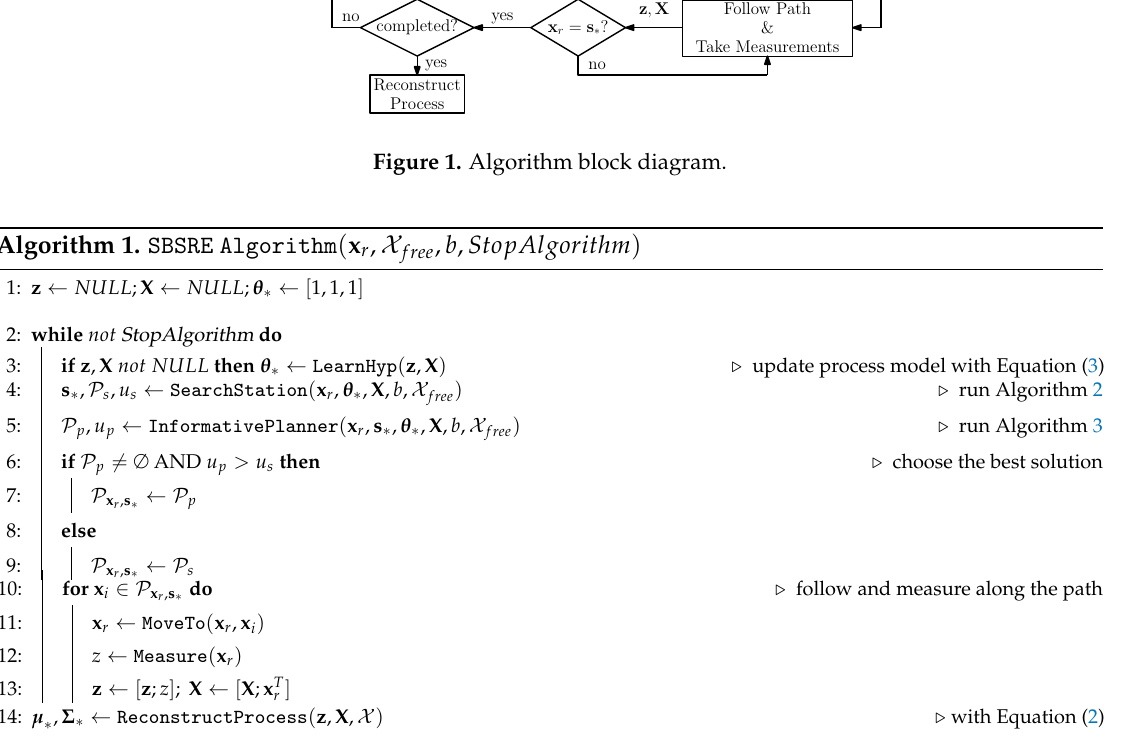
Figure 1. Algorithm block diagram.